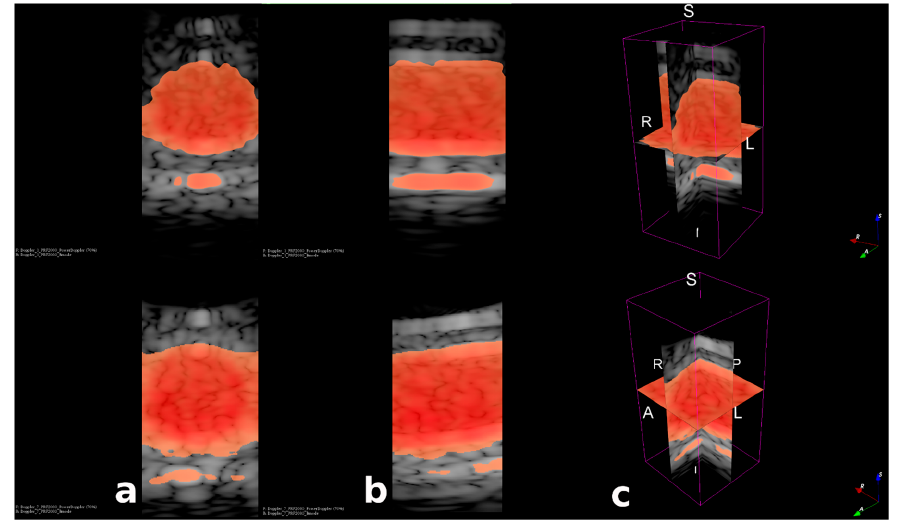
Figure 7. Experimental data acquired with 9 PW on a standard cyst phantom. Different configurations of the US array were used: full array, 1 line ON-1 line OFF, 2 lines ON-2 lines OFF, 4 lines ON-4 lines OFF, middle ON and 1 line ON-3 lines OFF. The shown planes, ( x , z ) (first row) and ( y , z ) (second row) are taken in the center of the US device. A dynamic of 50 dB has been used in all the images.